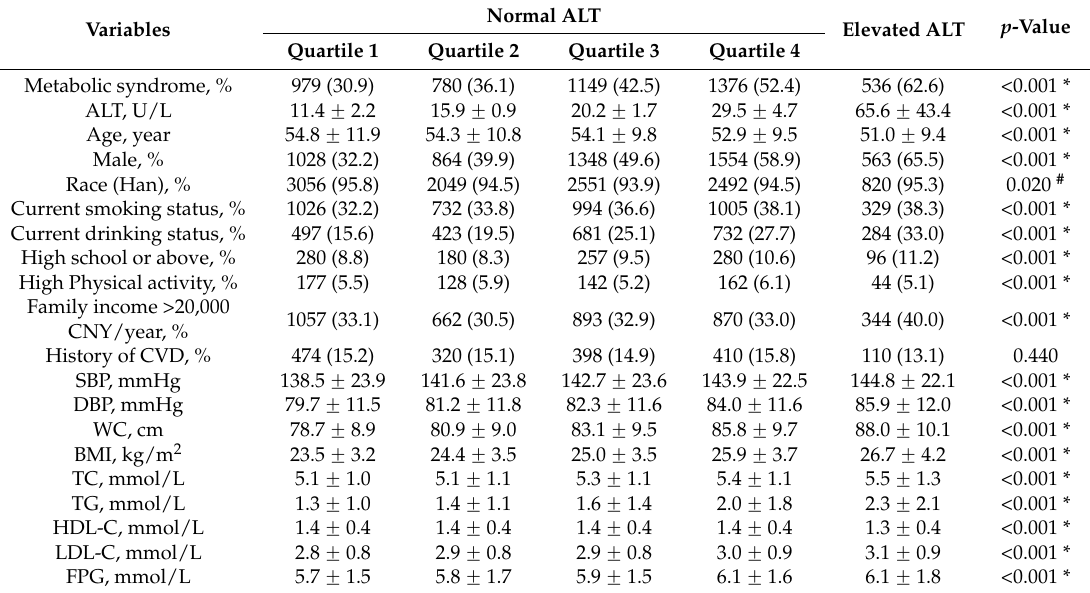
Table 2. Characteristics of subjects according to the ALT quartiles ( n = 11,573).